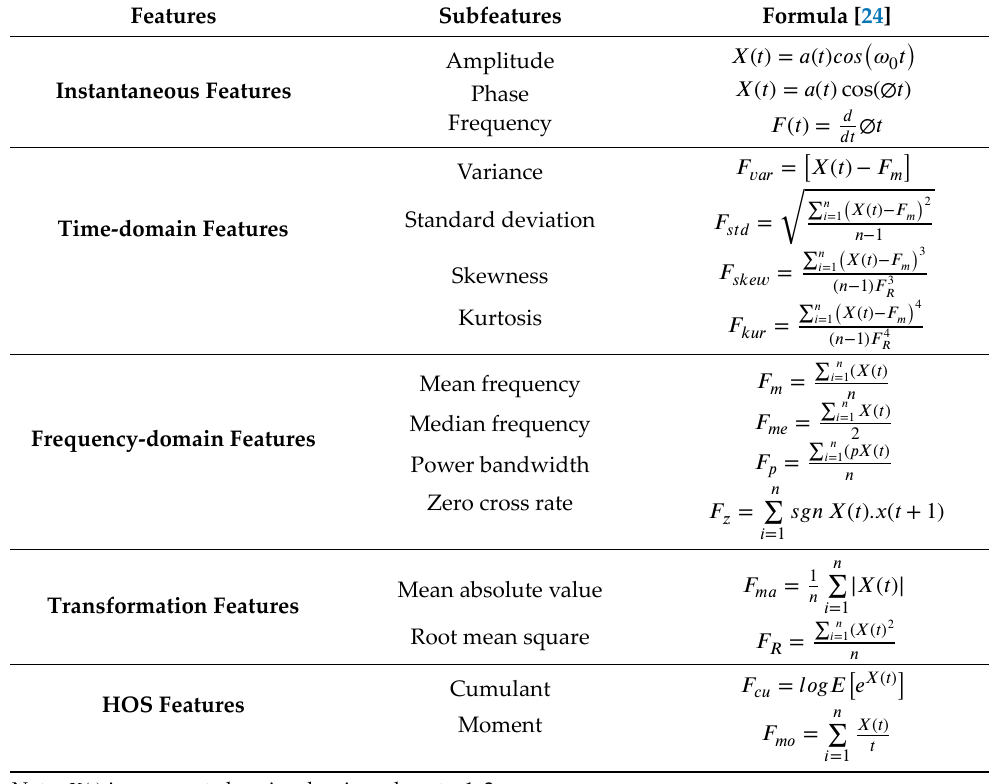
Table 2. Feature